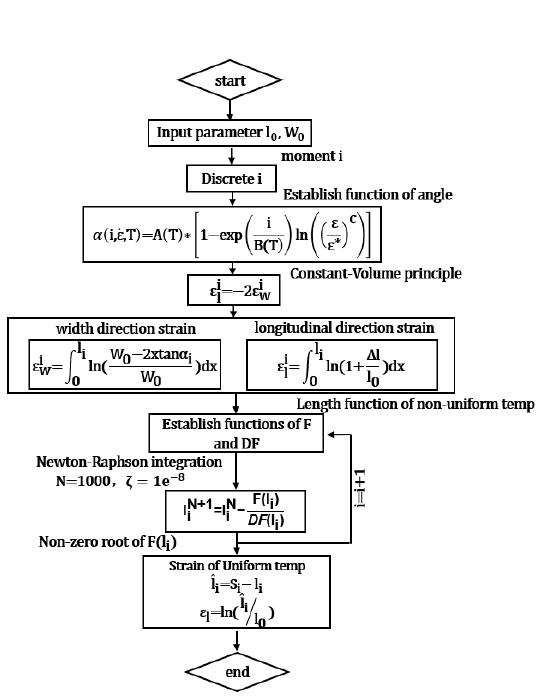
Figure 5. The calculation procedure of the correction model.